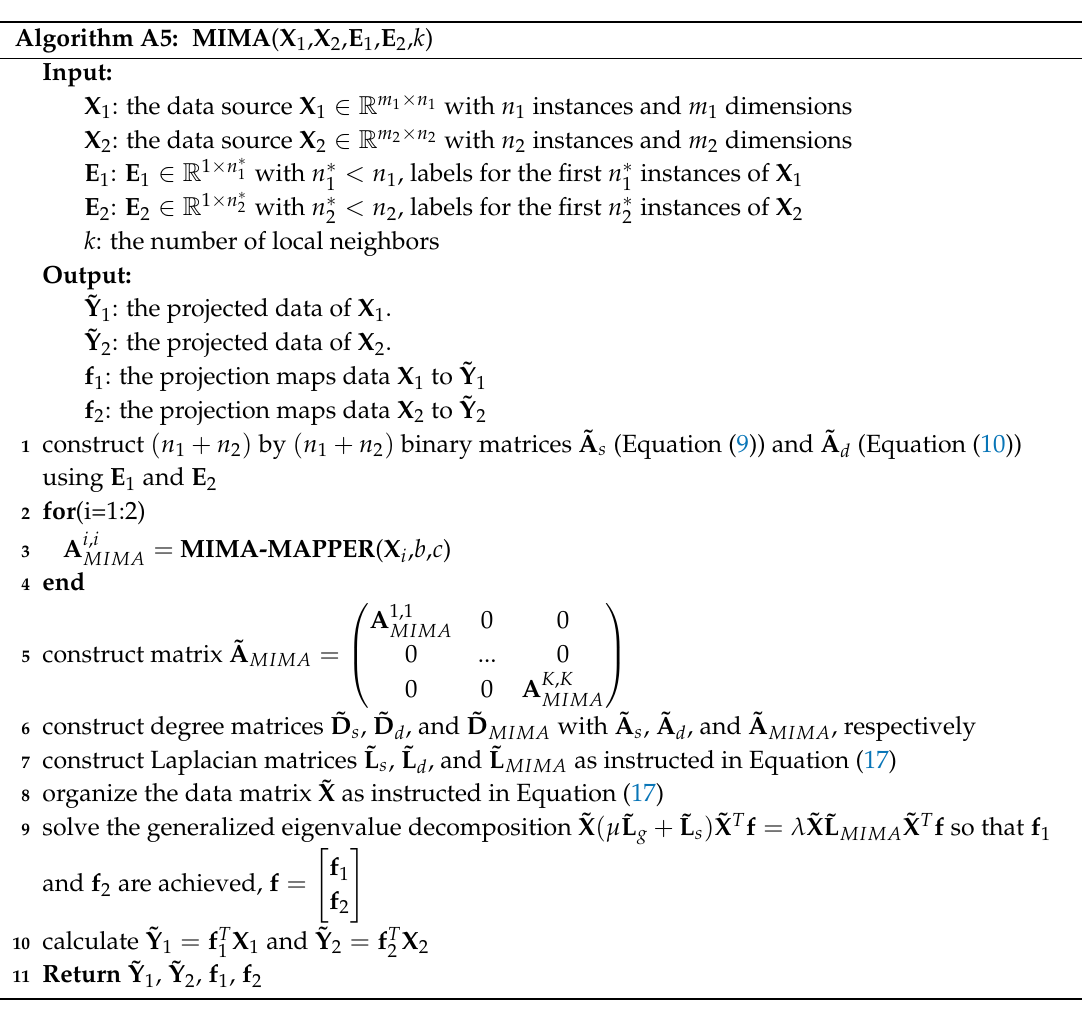
Algorithm A5: MIMA ( X 1 , X 2 , E 1 , E 2 , k